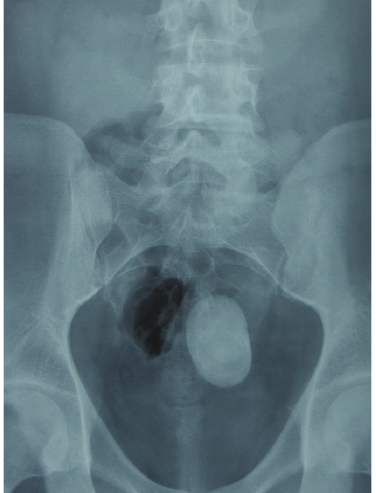
Figure 1: Preoperative direct urinary system radiography.